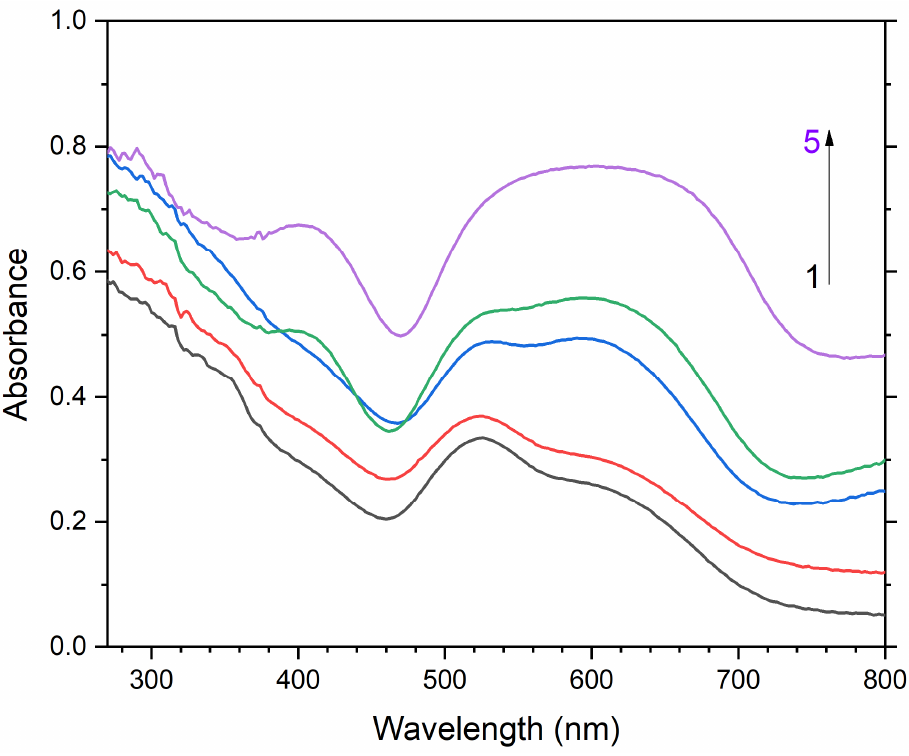
Figure 11. Spectra of diffuse absorption of haüyne (Sample 3): unheated sample (1) and samples heated at 200 ◦ C (2), 400 ◦ C (3), 600 ◦ C (4), and 800 ◦ C (5).